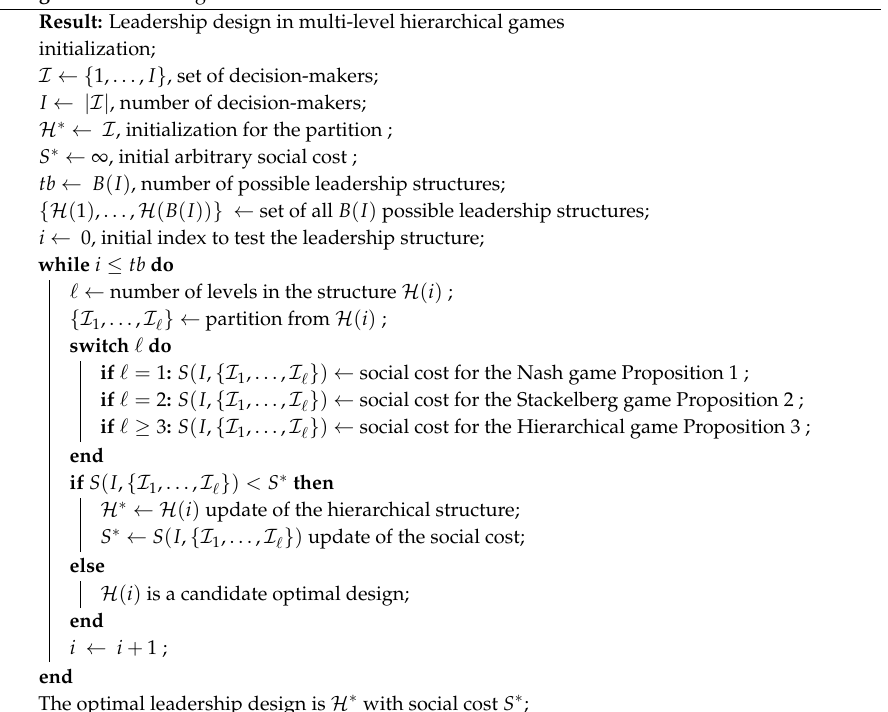
Algorithm 1: Finding the best hierarchical